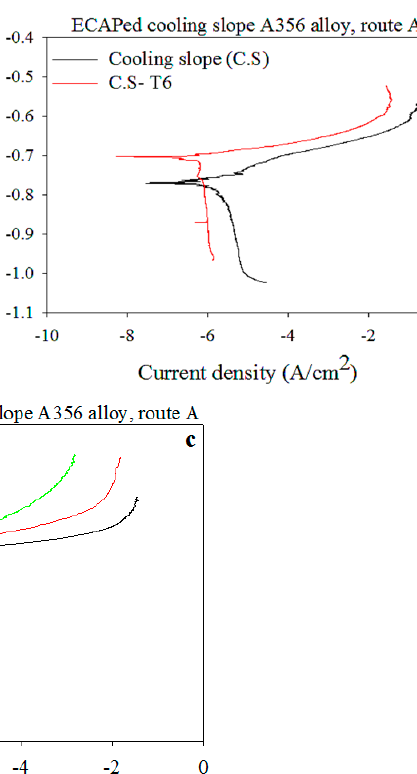
Table 2. Average of corrosion rate (CR), polarization resistance ( Rp ) and current density ( I corr ).